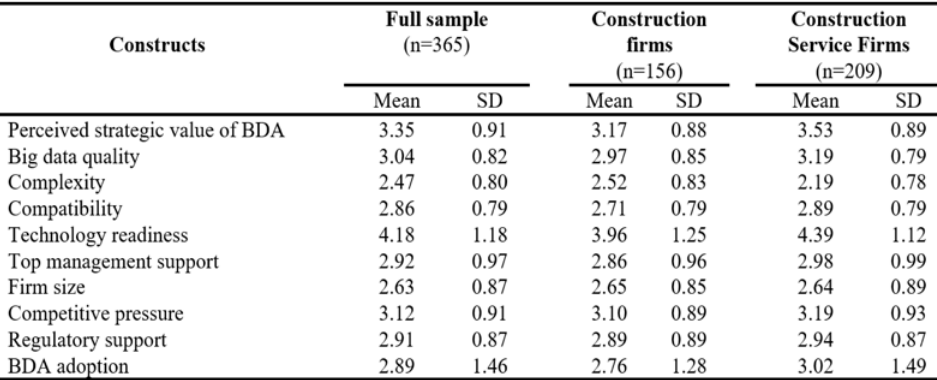
Standard deviation and mean of sub-samples and full samples